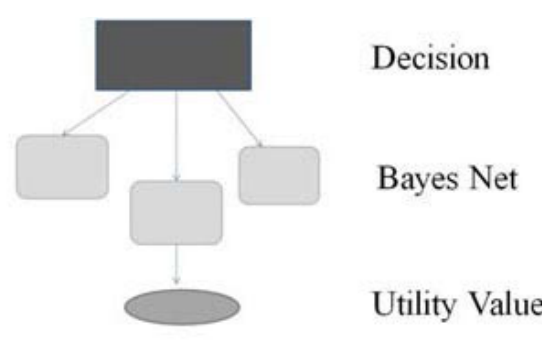
Fig. 1. The structure of a Bayesian Belief